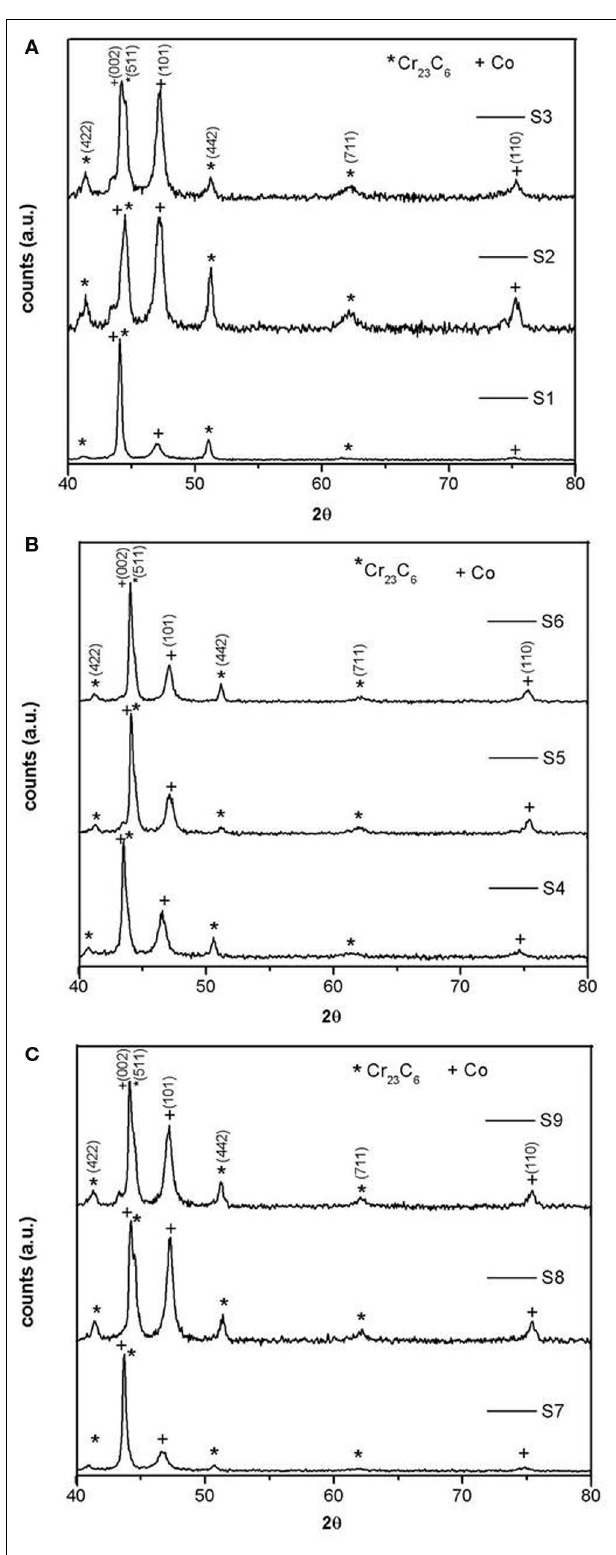
FIGURE 3 | Influence of heat treatment on constituent phases in laser processed Co-Cr-Mo alloy . (A) S1 to S3, (B) S4 to S6, (C) S7 to